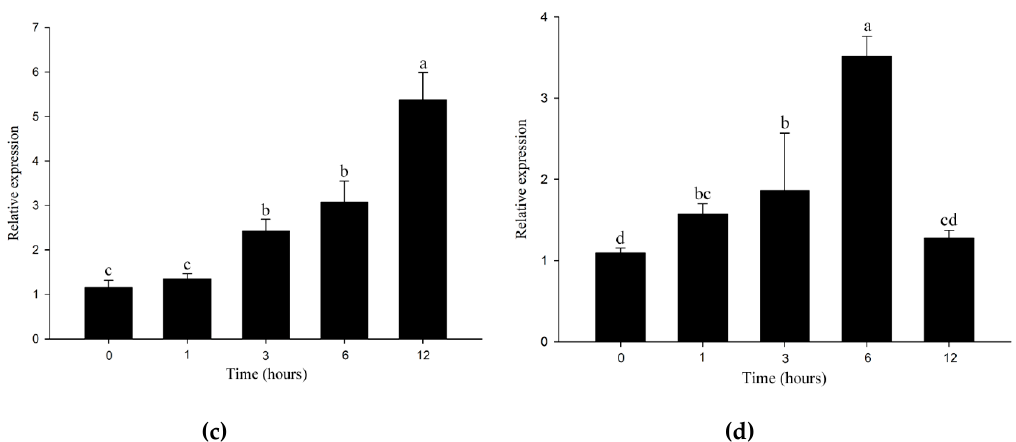
Figure 5. Expression profiles shows IcSRhO1 gene expresses differently in different tissues including leaf, vine, root, flower and seed ( a ). The expression of IcSRO1 is induced by different abiotic stressed: ( b ) Salt, ( c ) PEG, ( d ) ABA. The abundance of IcSRO1 transcripts increased to a peak at 6 h after salt and ABA treatments and decreased at 12 h, while they increased to the peak at 12 h after PEG treatments. The data represent the means ± SDs of three independent biological replicates. The different letters in the bar graphs indicate significant differences at p < 0.05.